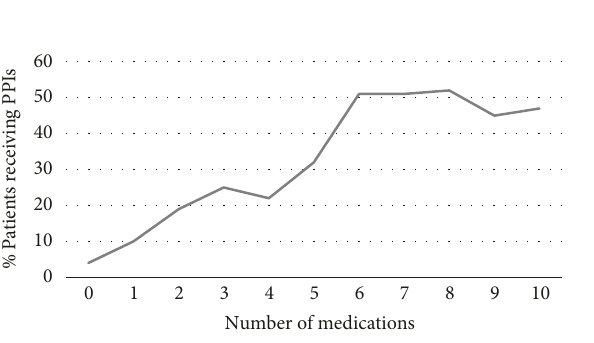
Figure 1: Percentage growth of patients receiving PPIs over the number of